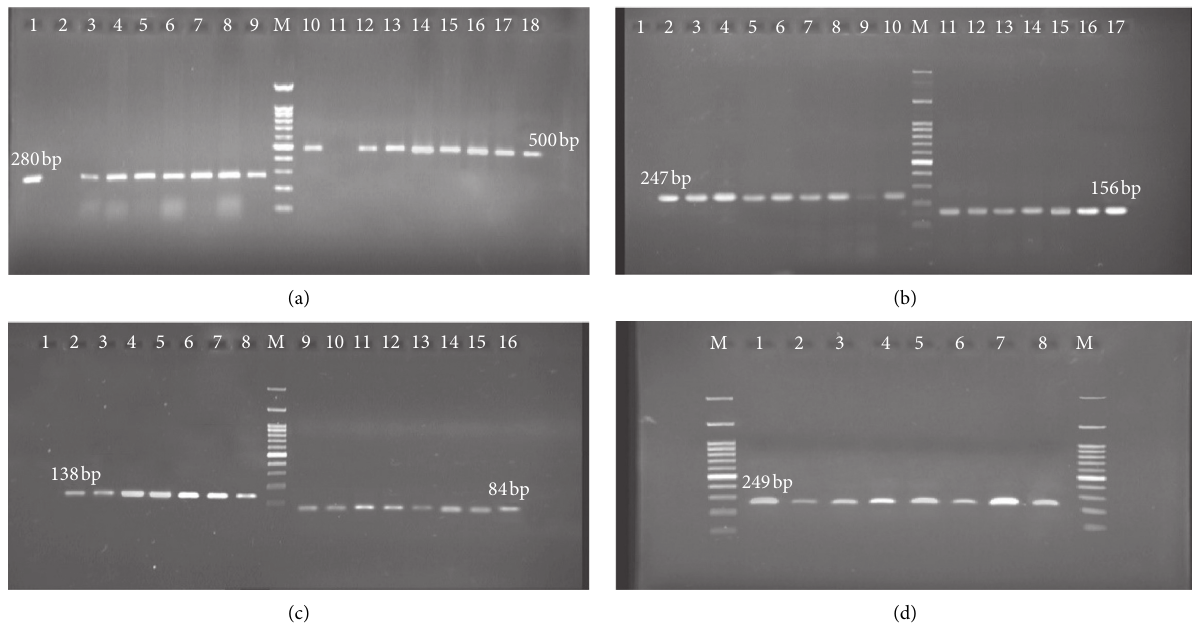
Figure 2: The amplification and gel electrophoresis agarose 2% of EP genes in P. aeruginosa . (a) mexA with 503bp, mexB with 280bp; well 1: positive control, wells 3 to 9: positive strains with mexB ; well 10: positive control, and wells 11 to 18: positive strains with mexA . (b) oprM with 247bp, oprD with 156bp; well 2: positive control, wells 3 to 10: positive strains with oprM ; well 11: positive control, and wells 12 to 18: positive strains with oprD . (c) tetA with 138 bp, tetR with 84bp; well 1: positive control, wells 2 to 7: positive strains with tetA ; well 7: positive control, and wells 8 to 14: positive strains with tetR . (d) emrE with 249bp; well 1: positive control and wells 2 to 8: positive strains with emrE. M Ladder